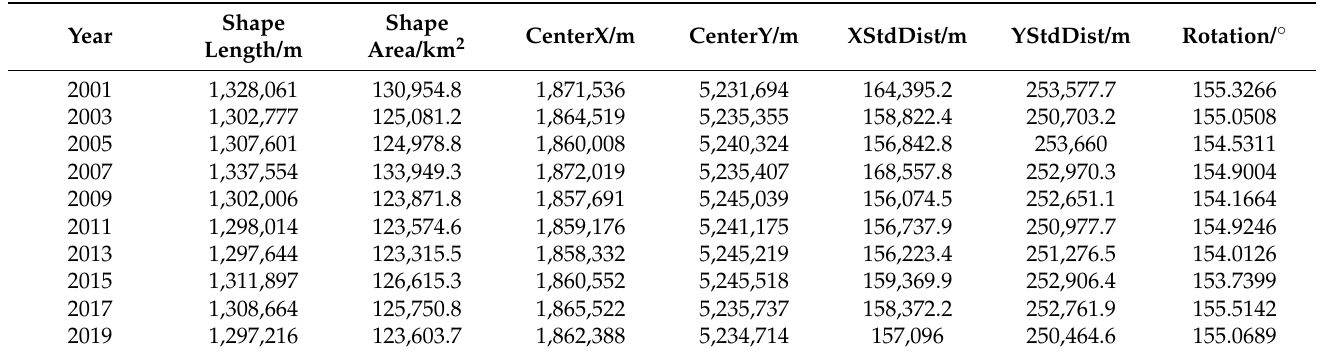
Table 2. Changes in the standard deviation ellipse of the carbon sink in the